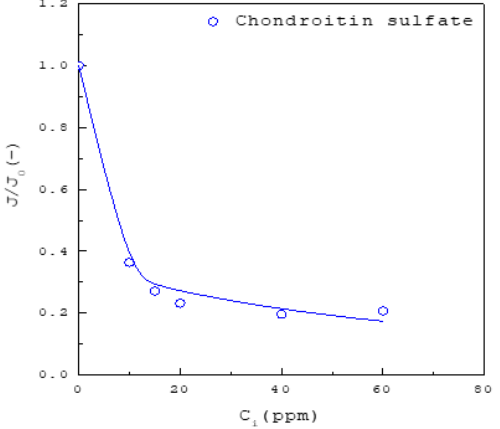
Figure 5. The decrease of J with increasing inhibitor concentration for the solutions in the presence of Figure 5. The decrease of (cid:3011) with increasing inhibitor concentration for the solutions in the presence J 0 (cid:3011) (cid:3116) chondroitin sulfate for S = 13.65 at 37 ◦ C. The solid line is a visual guide. Figure 5. The decrease of (cid:3011) with increasing inhibitor concentration for the solutions in the presence of chondroitin sulfate for 𝑆 = 13.65 at 37 °C. The solid line is a visual guide. (cid:3011) (cid:3116) of chondroitin sulfate for 𝑆 = 13.65 at 37 °C. The solid line is a visual guide.